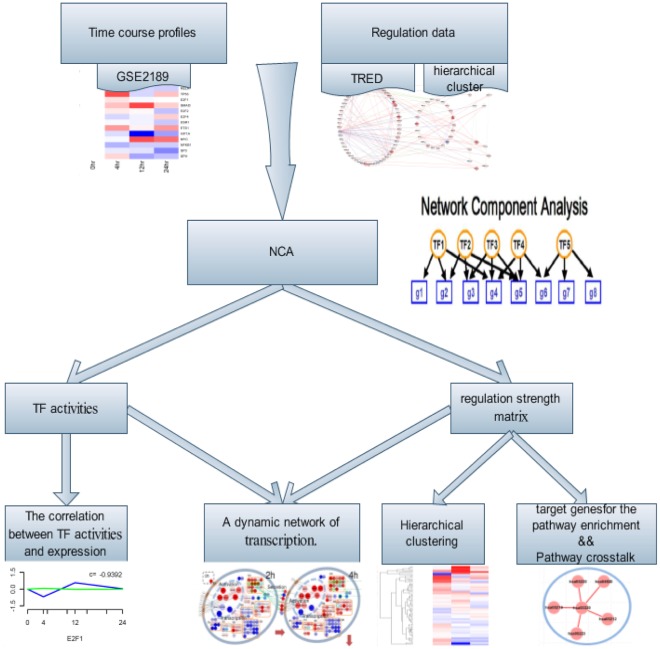
Flowchart of dynamic transcriptional regulatory network construction.